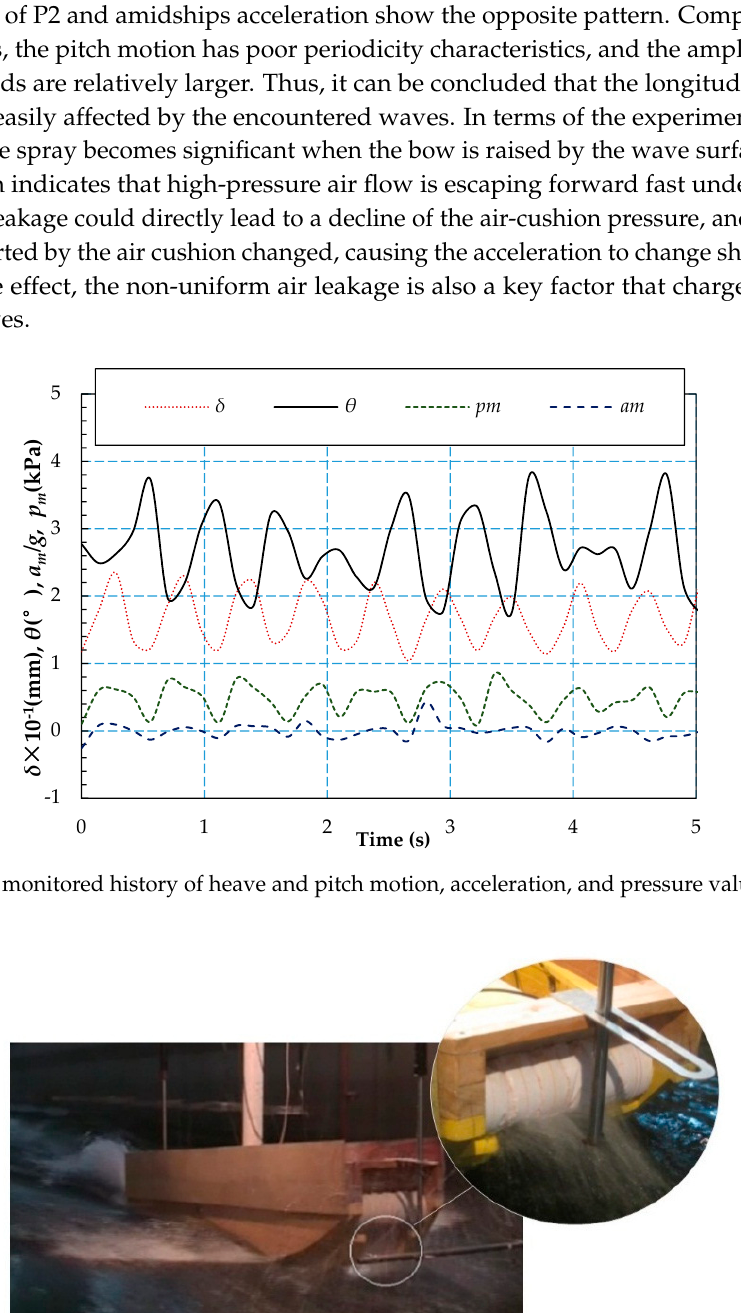
Figure 8. Test speeds on the curve of non-dimensional resistance versus Froude number.